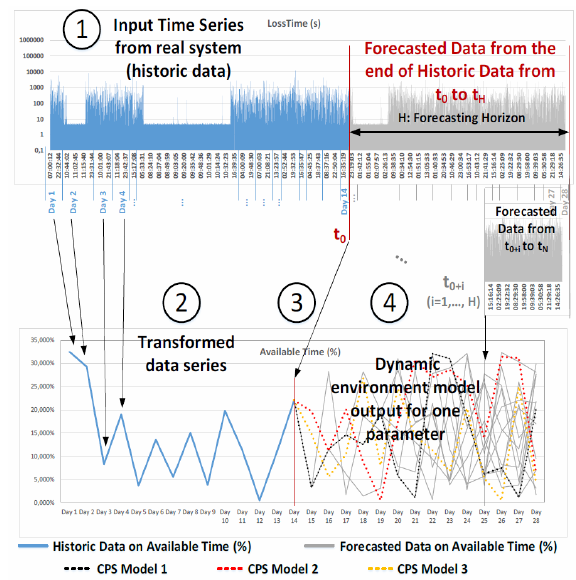
Figure 3. DEMGM input time series, transformed data series and dynamic environment model output for one